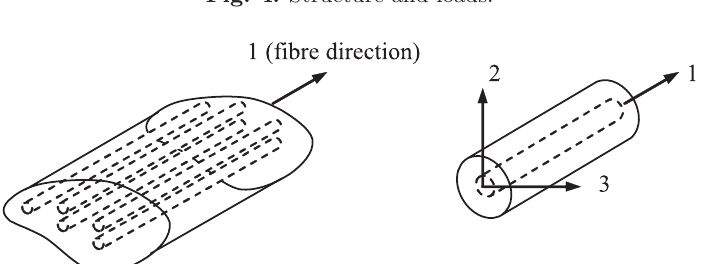
Fig. 4. Structure and loads.